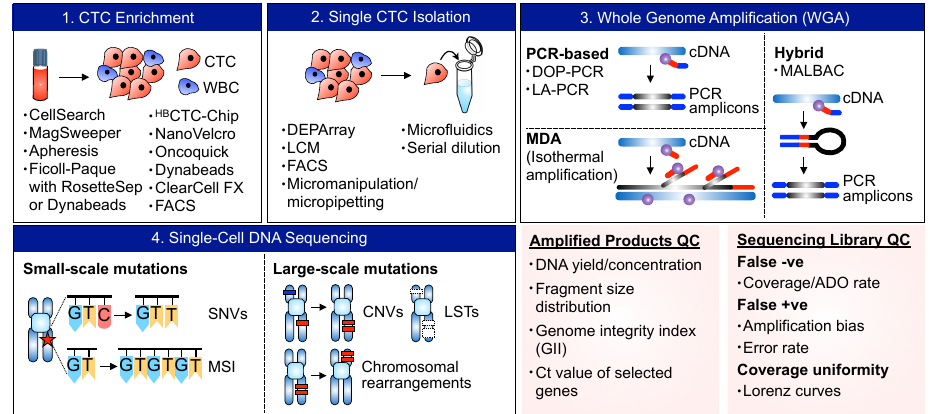
Figure 1. The standard workflow and existing technologies for scCTC sequencing. CTCs are primarily enriched from a whole blood sample, and are isolated as single cells for subsequent downstream molecular analyses. For genomic analysis of whole genome / exome, whole-genome amplification (WGA) is performed and amplified DNA products are QC-checked prior to